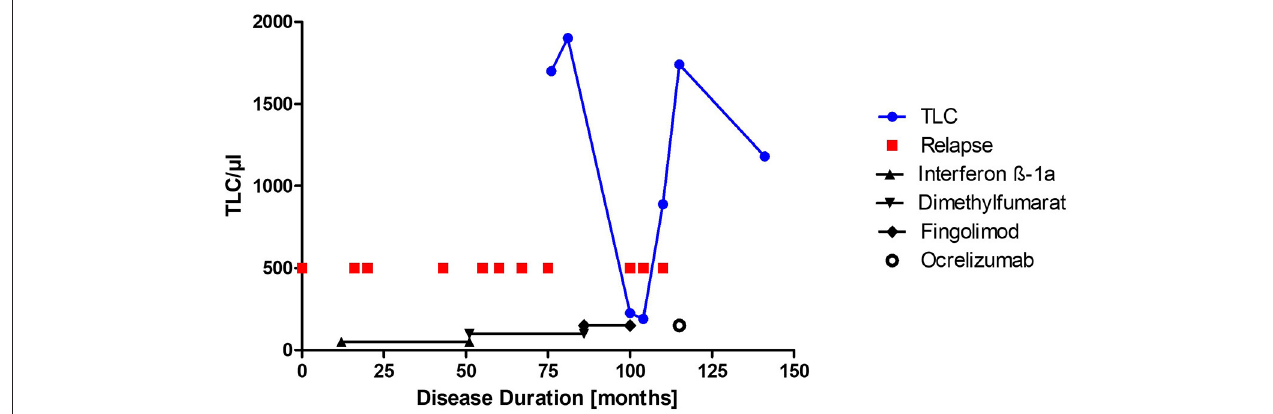
FIGURE 2 | Clinical course and total lymphocyte count. Total lymphocyte count (TLC)/ µ l is depicted over the disease course. Relapses are shown as red squares. Duration of disease modifying therapies is shown with the black symbols, respectively. Ocrelizumab therapy was initiated and is still